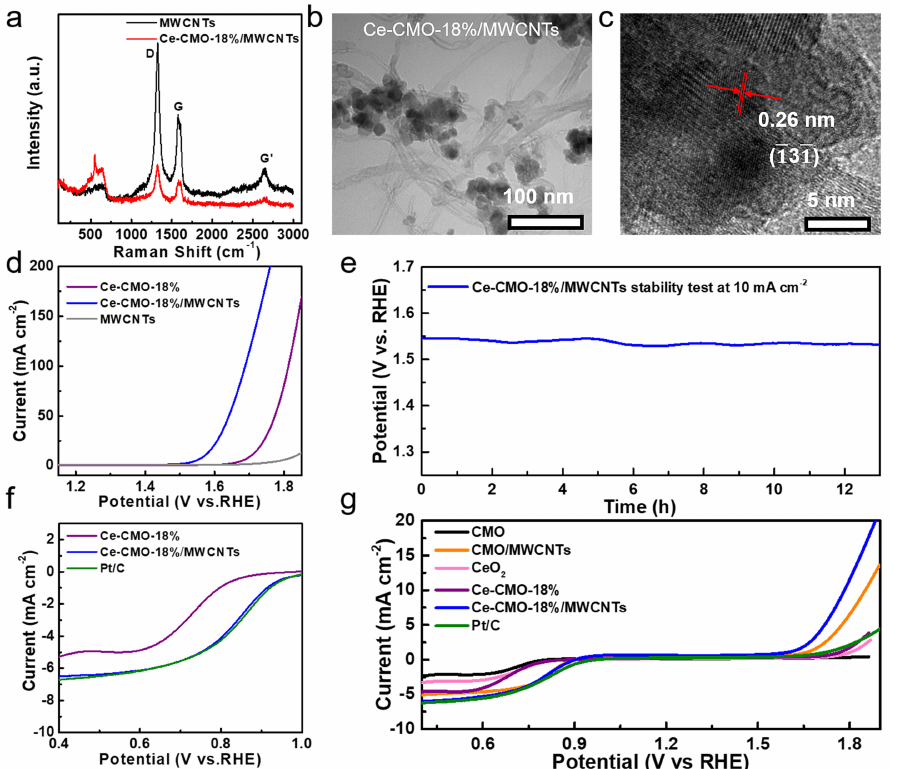
Figure 4. ( a ) Raman spectra of MWCNTs and Ce-CMO-18%/MWCNTs; ( b ) TEM image and ( c ) HRTEM image of Ce-CMO-18%/MWCNTs; ( d ) the OER LSV polarization curves in 1 M aqueous KOH at 10 mV s − 1 ; ( e ) long-term chronopotentiometric curve test of Ce-CMO-18%/MWCNTs at a current density of 10 mA cm − 2 ; ( f ) ORR LSV polarization curves of CMO, Ce-CMO-18%, Ce-CMO- 18%/MWCNTs, and Pt/C in O 2 -saturated 0.1 M KOH solution at 1600 rpm; ( g ) total LSV curves of the as-obtained samples in the ORR and OER